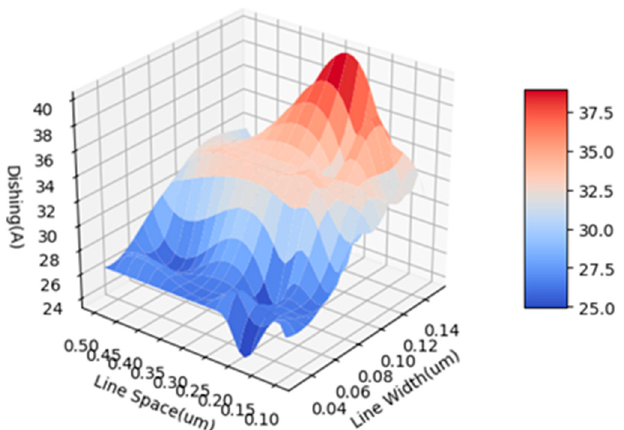
Figure 6. The dishing defects of predictions of the density-step-height (DSH) based chemical mechanical polishing (CMP) model. The root mean square error (RMSE) is 4.17 A.